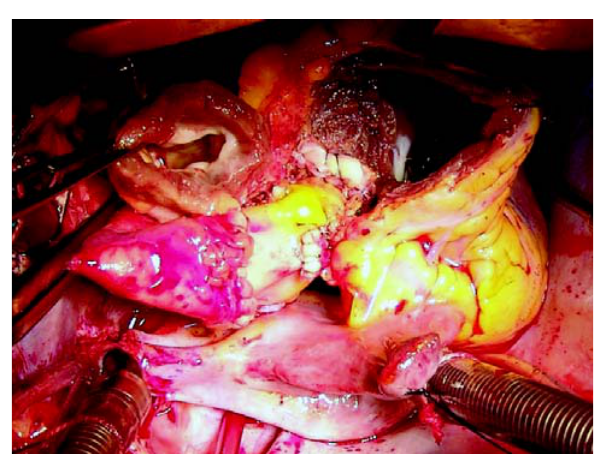
Fig. 2 – Auto-enxerto pulmonar implantado em posição aórtica e